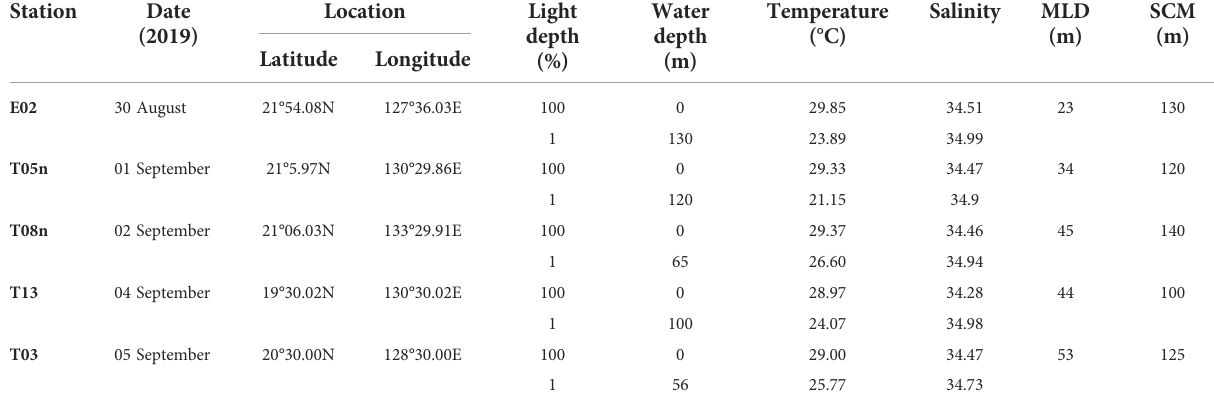
TABLE 1 Station information in the study area (Philippine Sea) during 2019.